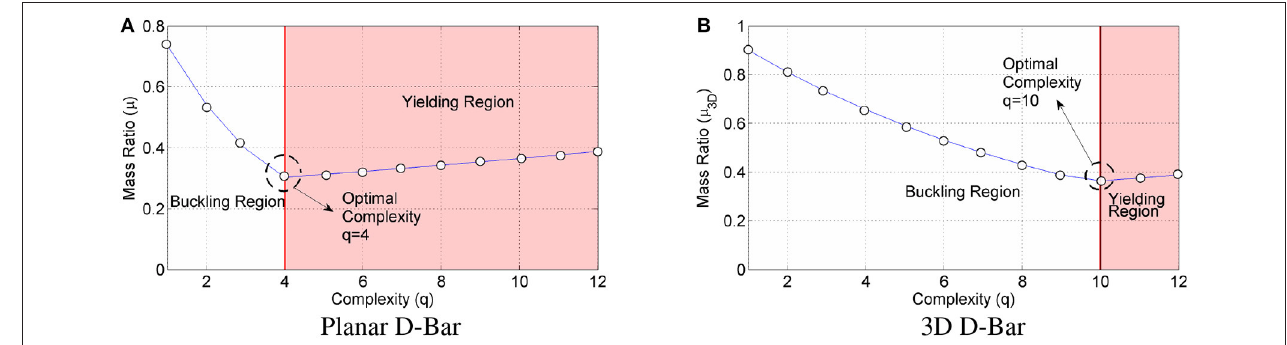
FIGURE 9 | Mass ratio (Equation 4) and Mass ratio (Equation 5) for parameters given in Example 4. (A) Planar D-Bar. (B) 3D